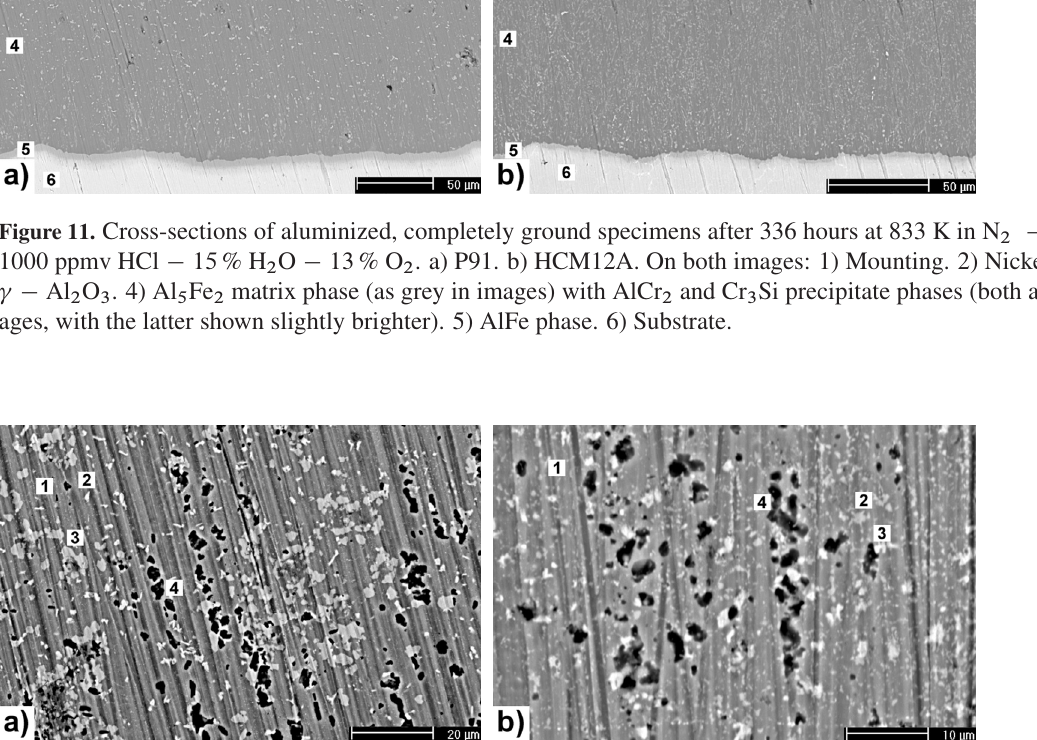
Figure 12. Back scattered electron images showing the surfaces of aluminized, completely ground, specimens after 336 hours at 833 K in N 2 (cid:3) 1000 ppmv HCl (cid:3) 15 % H 2 O (cid:3) 13 % O 2 . a) P91. b) HCM12A. On both images: 1) Al 5 Fe 2 matrix phase (grey). 2) AlCr 2 (light grey). 3) Cr 3 Si (brighter light grey). 4) Hole